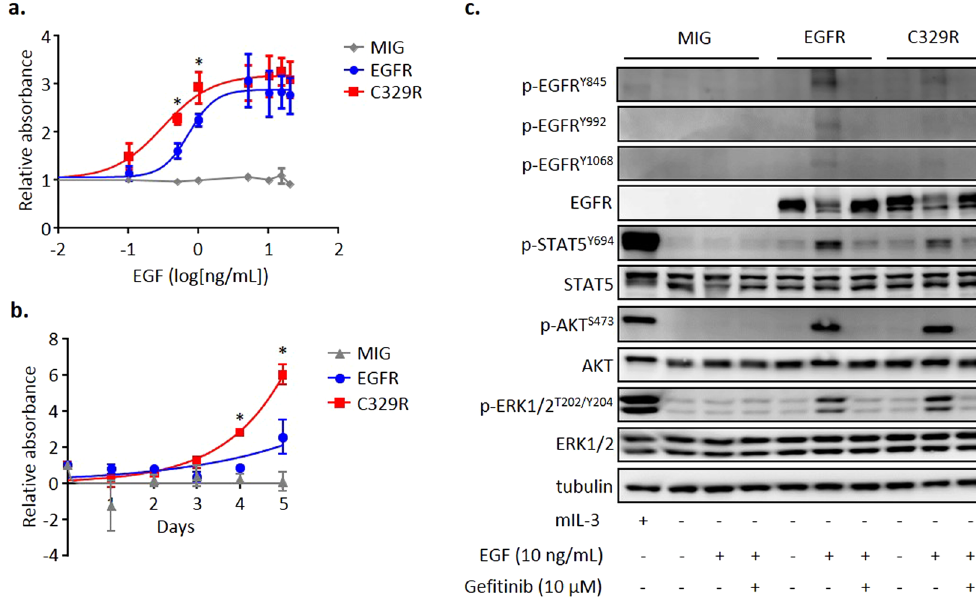
Figure 2. The EGFR C329R mutant increases sensitivity of BaF3 cells to EGF. ( a ) MTS assay was performed in BaF3/MIG, BaF3/EGFR and BaF3/C329R cells after 48 h of treatment with titrated concentrations of EGF (in the absence of mIL-3). For all treatments, cells were plated on day 0 at 10 5 cells/mL. Curves represent absorbance relative to no EGF. Points represent mean ± SE of 3 independent experiments. T-test * P < 0.05 (C329R vs. EGFR). ( b ) MTS assay performed in BaF3/MIG, BaF3/EGFR and BaF3/C329R cells during 5 days of culture with low dose of EGF (0.5ng/ml). Curves represent absorbance relative to day 0, when cells were plated at 10 4 cells/mL. Points represent mean ± SE of 3 independent experiments. T-test * P < 0.05 (C329R vs. EGFR). ( c ) Western blot analysis of EGFR phosphorylation and downstream signalling in response to EGF (in the absence of mIL3), and to EGF inhibition by gefitinib, in BaF3/MIG, BaF3/EGFR and BaF3/C329R using indicated antibodies. These are cropped blots, full-length blots are presented in Suppl. Figure